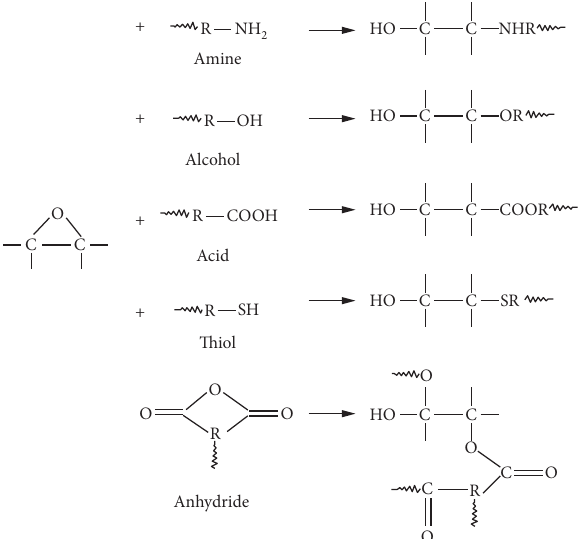
Figure 3: Reaction between epoxy and hardeners [11].